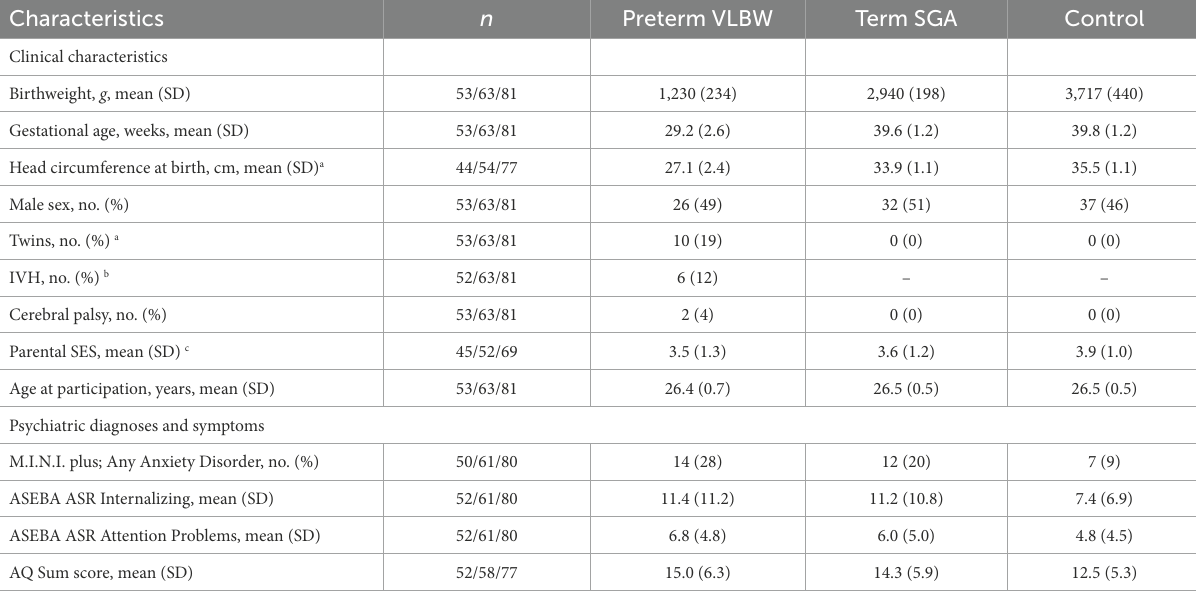
TABLE 1 Clinical characteristics and psychiatric diagnoses and symptoms at 26 years of age in the three study groups.